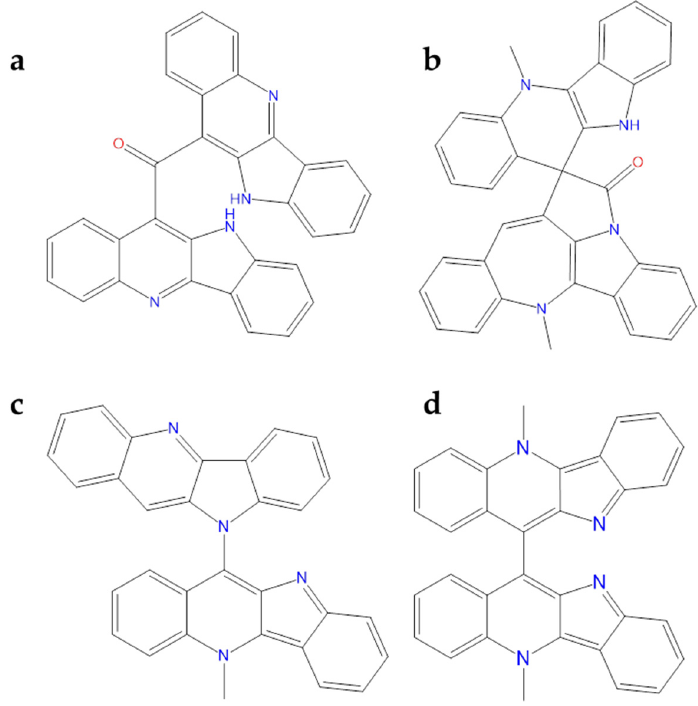
Figure 12. 2D structures of ( a ) cryptomisrine, ( b ) cryptospirolepine, ( c ) cryptoquindoline, and ( d ) biscryptolepine.